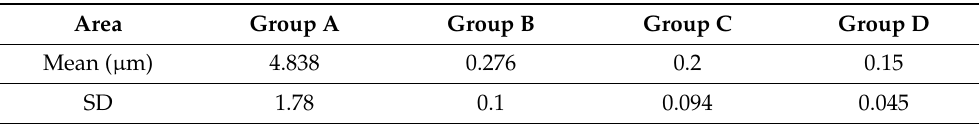
Table 1. Average irregular surface acquired after etching with hydrofluoric acid, diamond burs, and CO 2 laser, and control group.